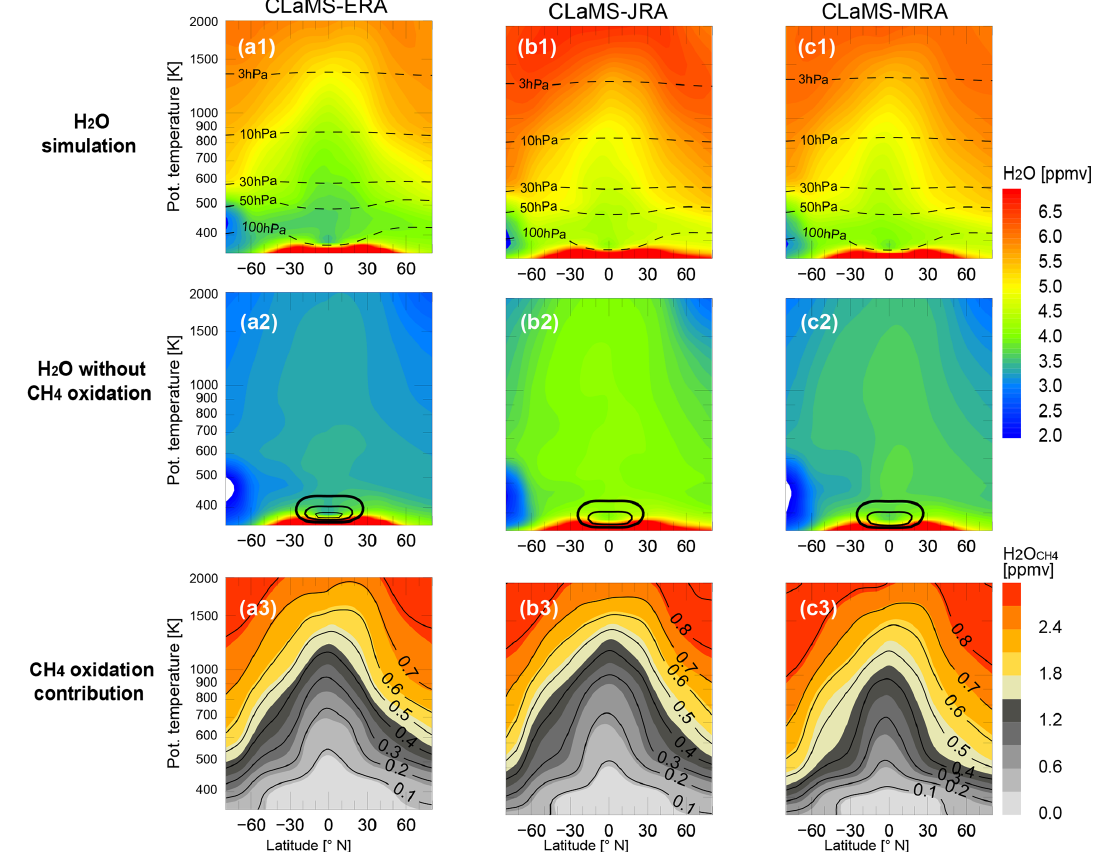
Figure 2. Comparison of climatological annual mean SWV during the CLaMS period (1985–2013). Top row (a1–c1) : annual-mean zonal- mean simulated H 2 O based on (left to right) CLaMS-ERA, CLaMS-JRA and CLaMS-MRA. Dashed lines mark the zonal-mean locations of isobaric surfaces. Middle row (a2–c2) : as in (a1–c1) but for simulated H 2 O without methane oxidation. These distributions highlight the effects of variations in H 2 O entry values (tropopause temperature). Black contours show zonal-mean temperatures of 192.5, 195 and 200K (from thin to thick lines) near the tropical tropopause. Bottom row (a3–c3) : as in (a1–c1) but for simulated H 2 O from CH 4 oxidation. The distributions reflect the effect of the BDC on water vapor produced by methane oxidation. Black contours show the fractional CH 4 oxidation ratio ( α